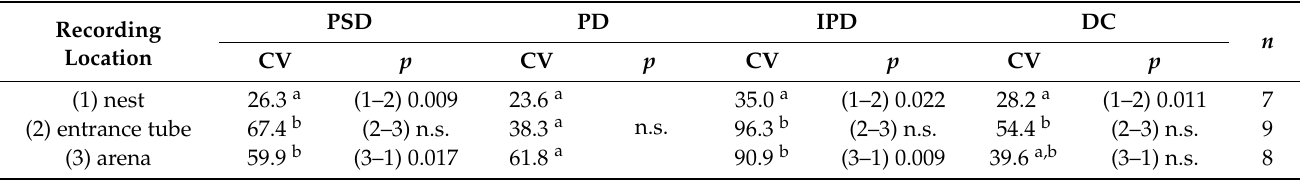
Table 2. Median coefficient of variation of thoracic vibration’s temporal structure per pulse train by A. ferruginea foraging (nest) and guarding vibrations (entrance tube,